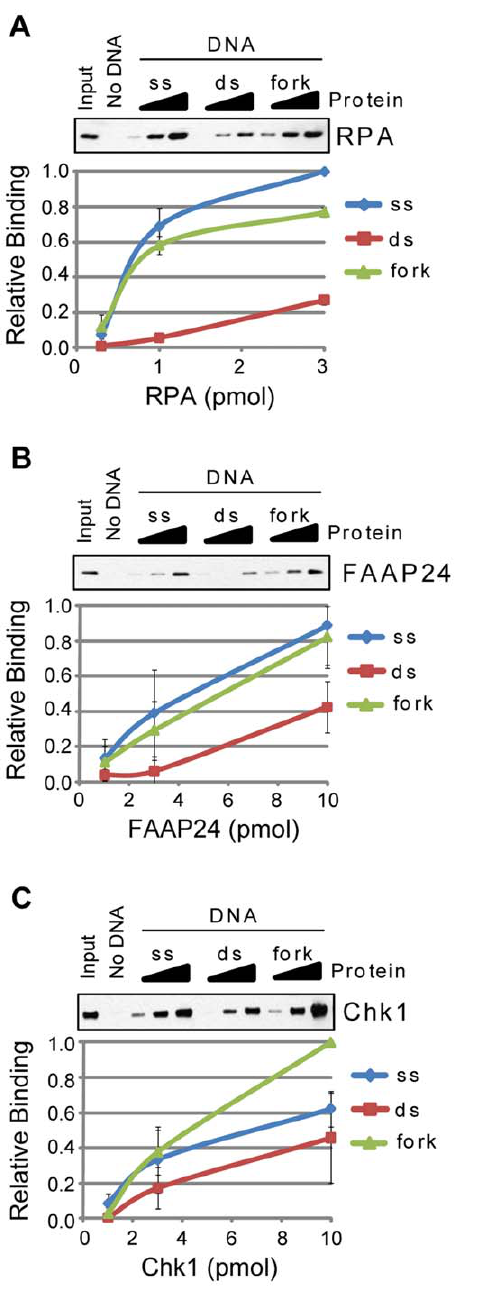
Figure 3. The DNA damage checkpoint sensors 9-1-1, ATRIP, and XPA preferentially bind branched DNA. The association of each of the indicated purified proteins with beads alone (No DNA) or to single-stranded (ss), double-stranded (ds), and branched, replication fork-like (fork) DNA bound to magnetic beads was analyzed by SDS- PAGE and immunoblotting. Each of the following proteins were analyzed for binding to each DNA structure: (A) 9-1-1, (B) ATRIP, and (C) XPA. Reactions were carried out as described in the Methods section.